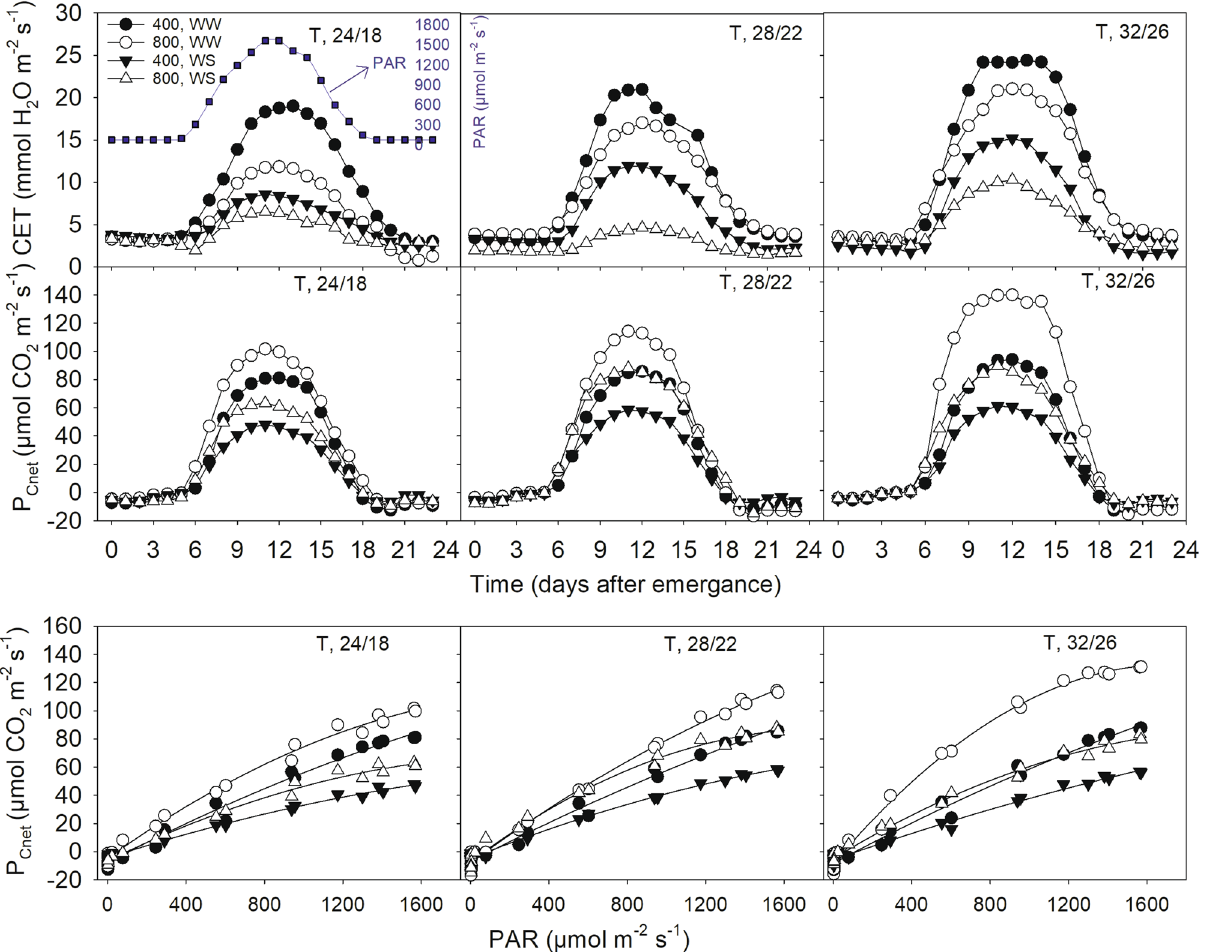
Figure 3. Daily soybean canopy net photosynthesis rates ( P Cnet ), canopy evapotranspiration (CET) and P Cnet light response curve for a representative sunny day 58 days after emergence) as influenced by two levels of CO 2 (400 and 800 µmol mol −1 ) and irrigation (WW, well water; WS, water stress) across three levels of temperature (T, day/night, °C). Datapoints represent the measured hourly mean. The diel photosynthetically active radiation (PAR, square symbols) for the day is also shown for the same day (top left panel). The P Cnet response to light (PAR) is shown in the bottom